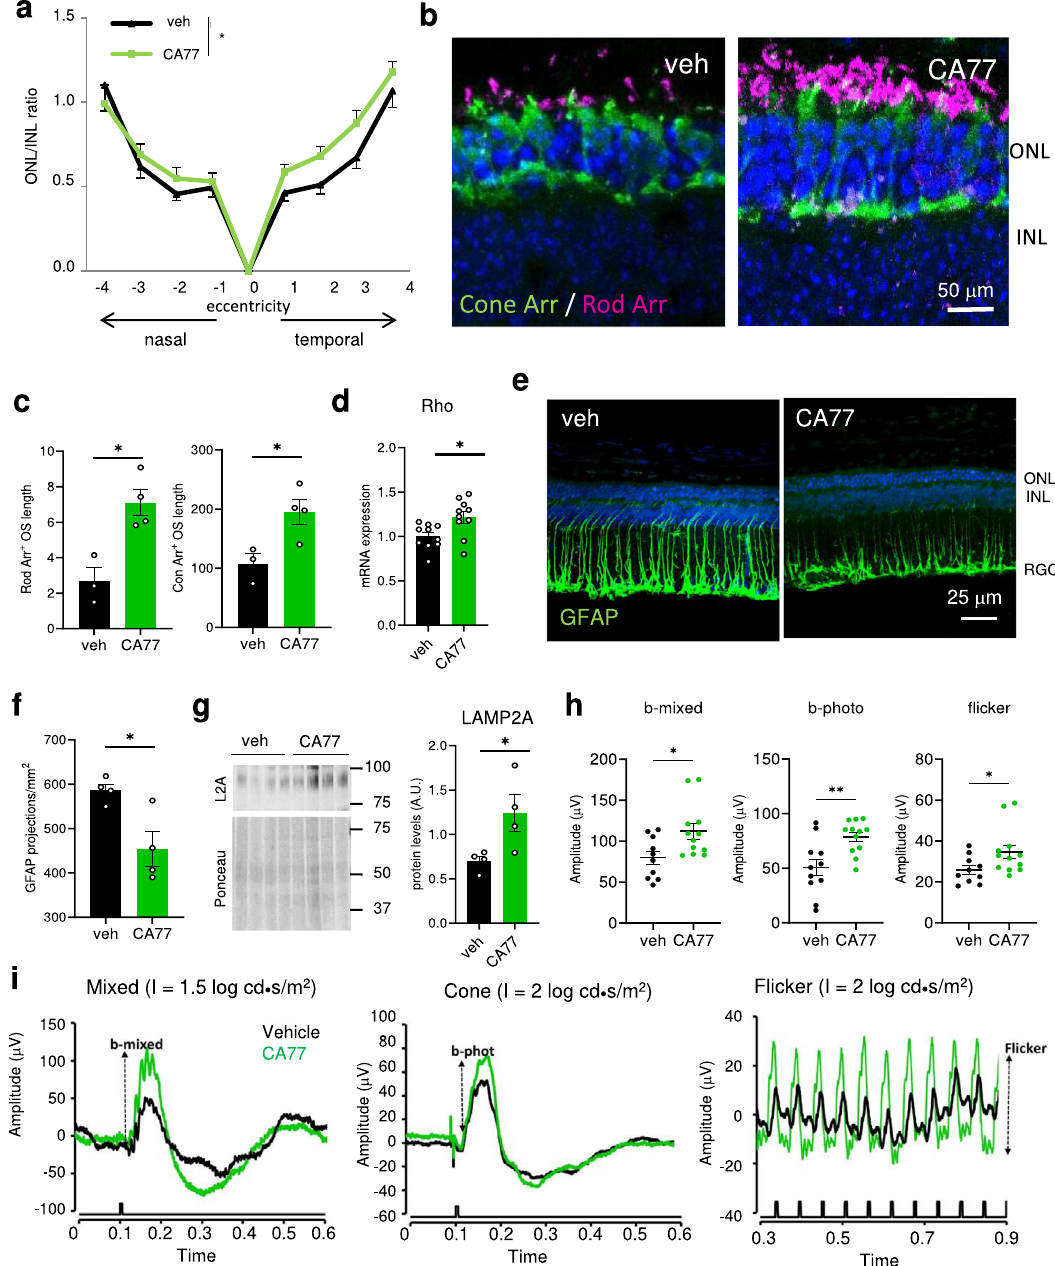
Fig. 6 CA compounds prevent rd10 retinas degeneration. a Ratio of the thickness of the outer nuclear layer (ONL) and inner nuclear layer (INL) in retinas of rd10 mice treated from P18 to P25 with daily i.p. injection of the vehicle only or 40 mg/kg bw of CA77. n = 8 (vehicle) and 9 (CA treated), from 3 independent experiments. b Cone (green) and rod (magenta) arrestin markers in temporal central retina of rd10 mice treated as in a . Nuclei are highlighted with DAPI. c Quanti fi cation of outer segment (OS) length of the rods (left) and number of cones (right) measured in the whole retina with the markers used in b . n = 4 areas per animal, 4 mice per condition. d mRNA levels of rho in the same animals used in a . n = 10. e , f Representative image of the immunostaining for GFAP in the same retinas ( e ) and corresponding quanti fi cation of the GFAP projections ( f ). n = 4. g Immunoblot for the indicated proteins in retinas of mice treated as in a . 4 different mice are shown. Right : Densitometric quanti fi cation of L2A in n = 4 different mice. Values are expressed as arbitrary units. h , i Electroretinogram wave amplitudes at P33 from rd10 mice injected with CA77 or vehicle as in a ( h ) measured as shown in the traces ( i ). n = 10 veh and 12 CA77. Individual values and mean + s.e.m. are shown. Two-way ANOVA followed by Bonferroni ’ s multiple comparisons post-hoc test was used in a , and unpaired two-tailed t test in all others. * p < 0.05 and ** p < 0.01. Uncropped blots are in Supplementary Fig. 10. Source data and exact p values are provided as a Source Data fi